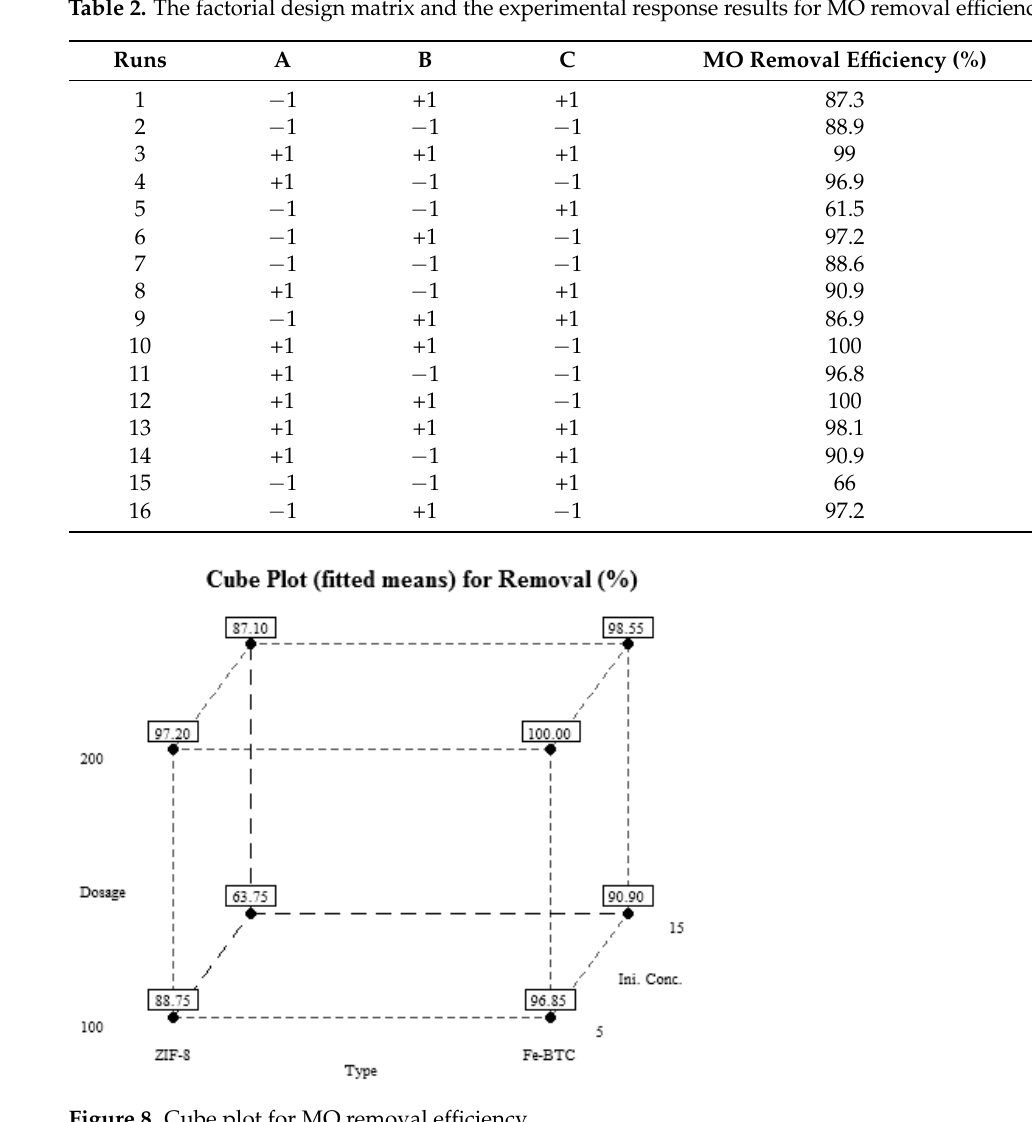
Figure 8. Cube plot for MO removal efficiency.